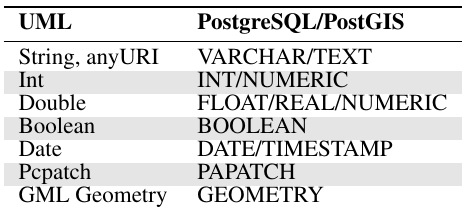
Table 1. Data type